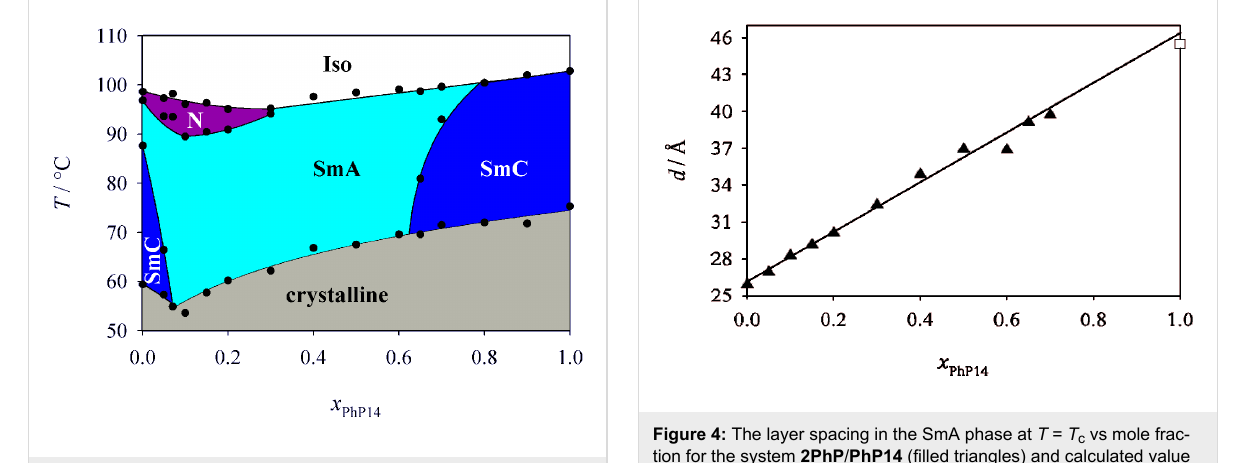
Figure 3: Phase diagram of the system 2PhP/PhP14 . Over a broad temperature and concentration range only the SmA phase is stable.